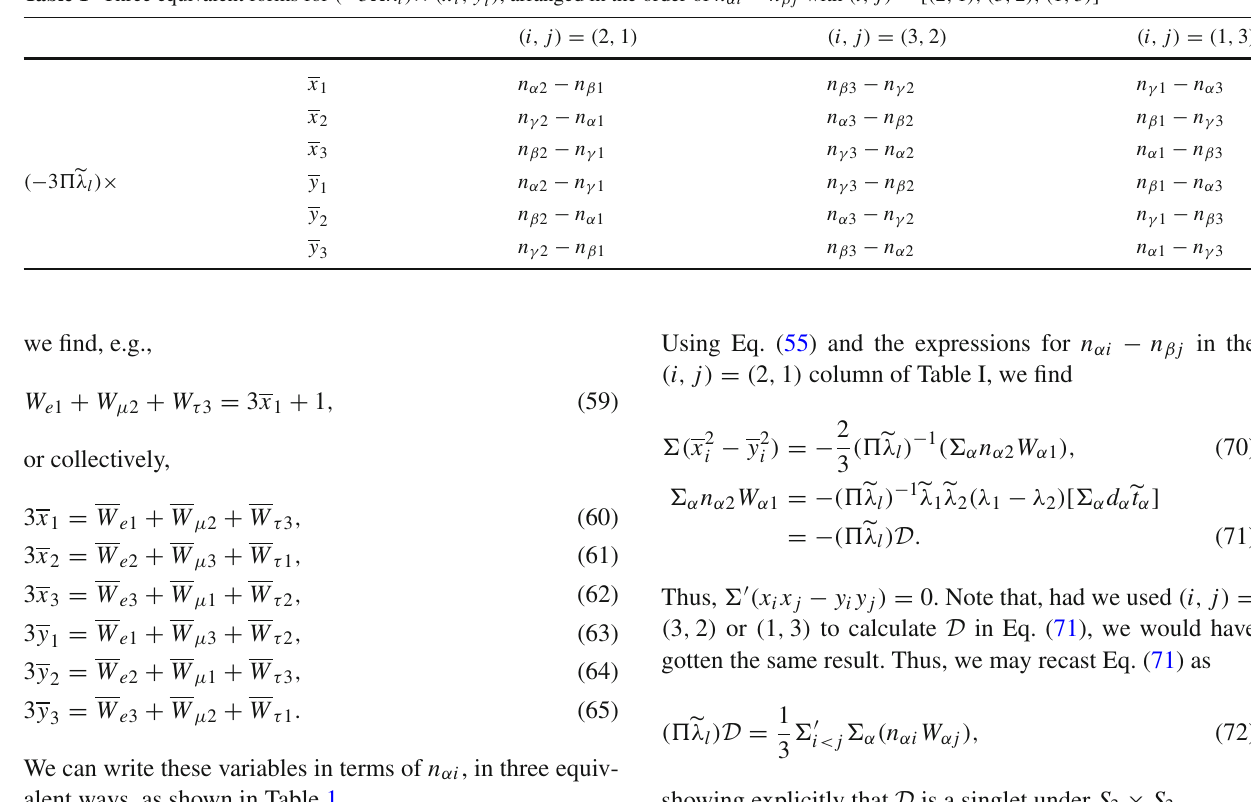
Table 1 Three equivalent forms for ( − 3 (cid:9) (cid:7) λ l ) × ( x i ; y i ) , arranged in the order of n α i − n β j with ( i , j ) = [ ( 2 , 1 ) ; ( 3 , 2 ) ; ( 1 , 3 )